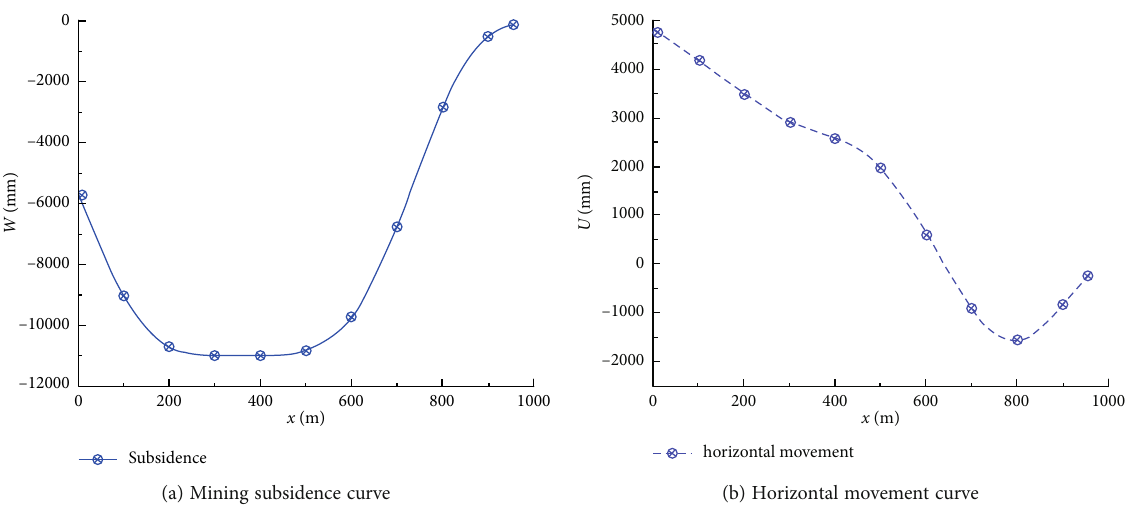
Figure 12: Numerical model of No. 92 pillar back fi